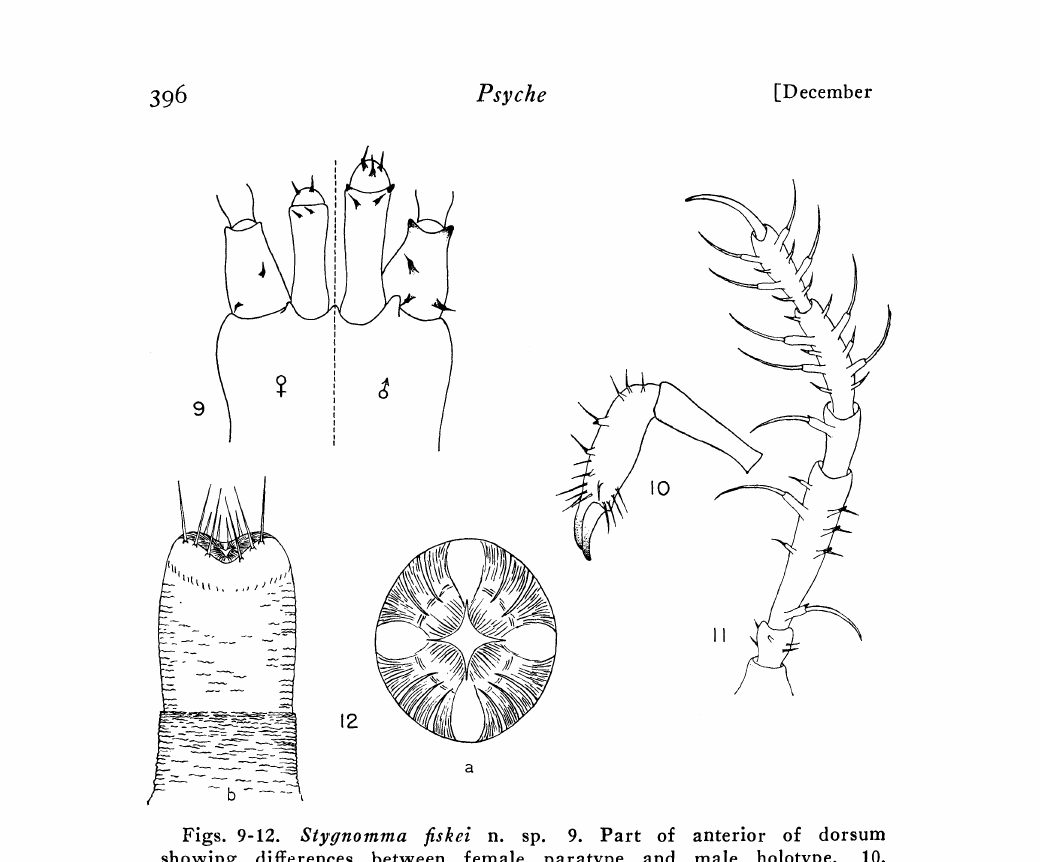
Figs. 9-12. Sty’#nomma fiskei n. sp. 9. Part of anterior of dorsum showing differences between female paratype and male holotype. 10. Lateral view of chelicera, female paratype. 11. Ventral view of palpus, female paratype. 12. Ovipositor; a. Ventral view. b. Frontal view. latella, 0.78 mm; tibia, 1.27 mm; tarsus, 0.95 mm; total length, 4.6o mm. First femur, 1.7I mm; total length, 6.78 mm. Second femur, 2.75 mm; total length, 11.6o mm. Third femur, 2.oo mm; total length, 7.7o mm, Fourth femur, 2.5o mm; total length, IO. IO